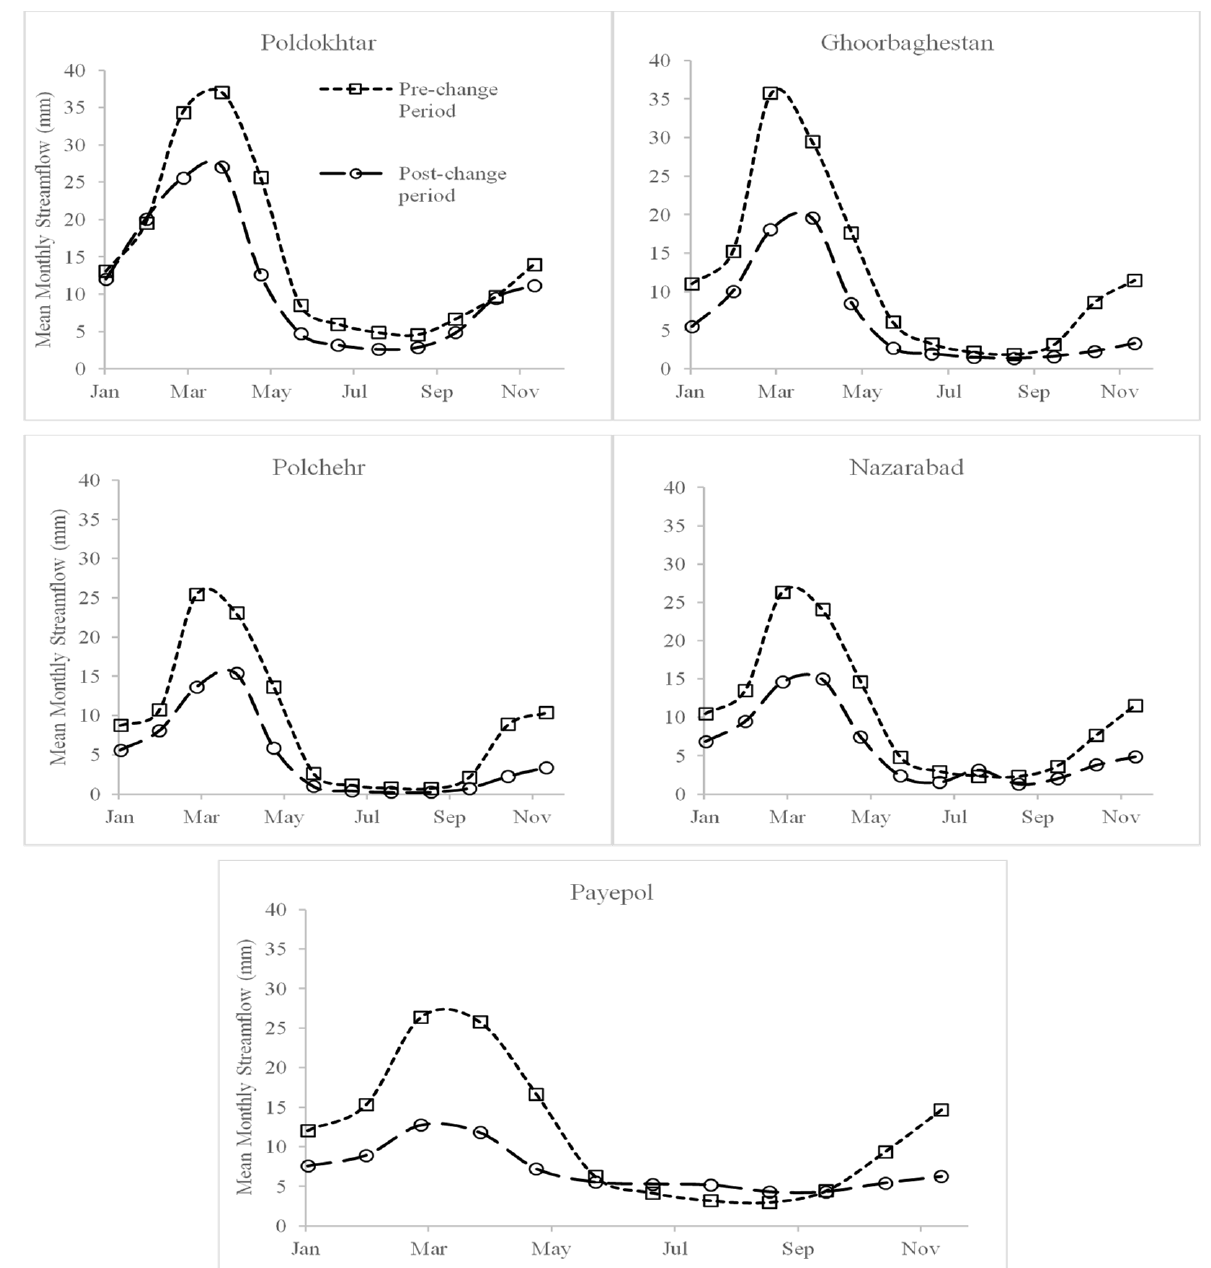
Figure 8. Mean monthly streamflow of the studied sub-basins during the pre-change (1) and post-change periods (2).